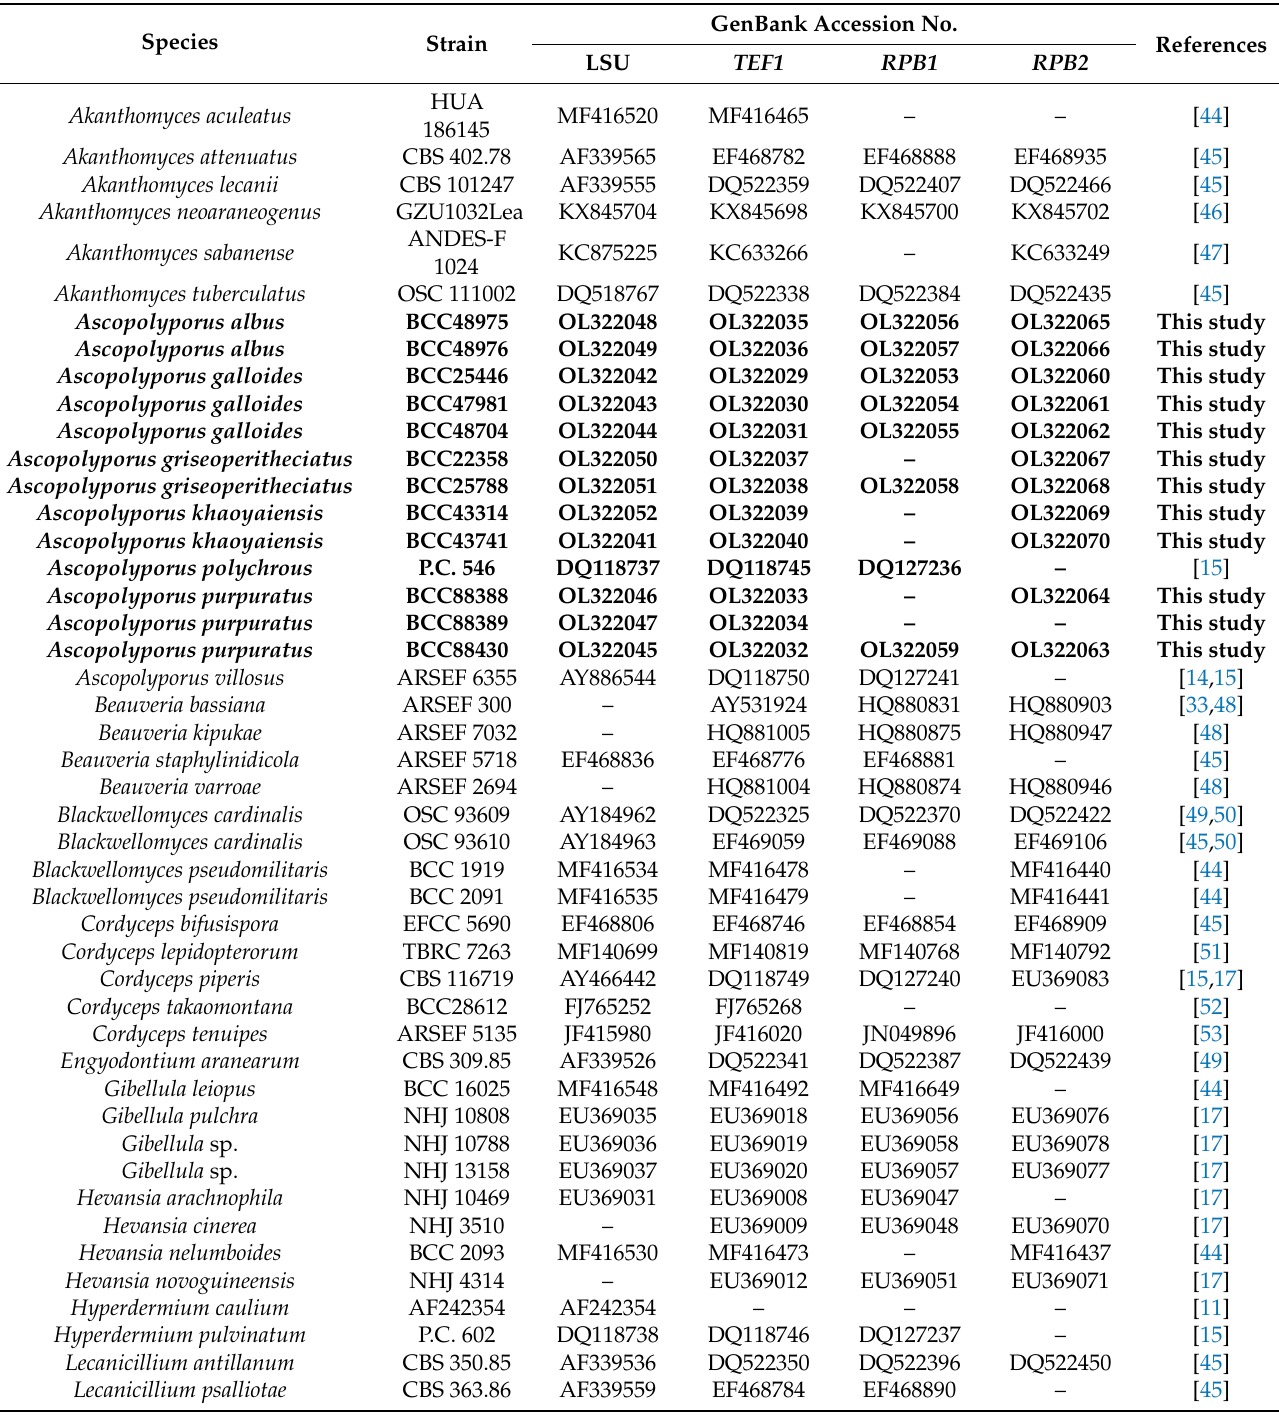
Table 1. List of species and GenBank accession numbers of sequences used in this study. Bold accession numbers were generated for this study. The symbol “–” denotes no available